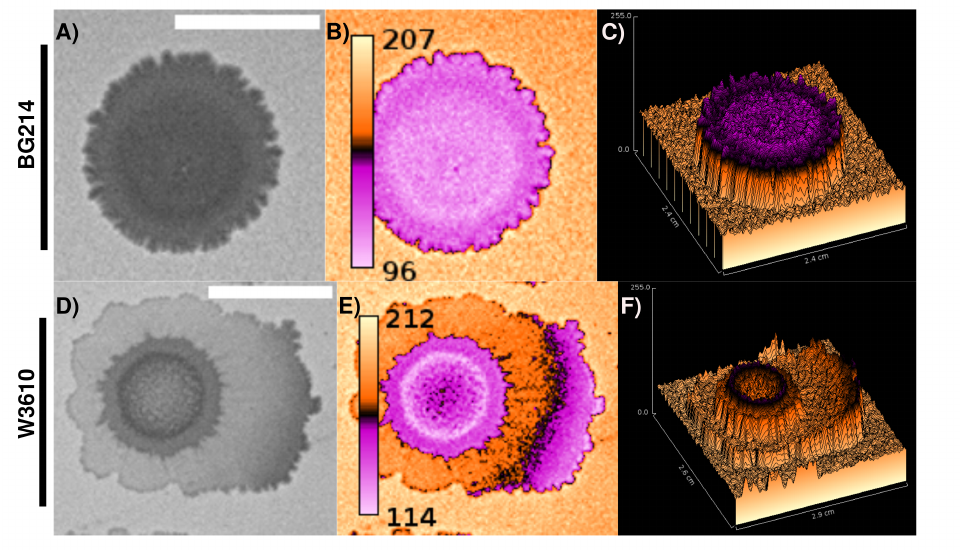
Figure 2. Characteristic B. subtilis colony differences. ( A ) BG214 shows characteristic cones located at the edges of the colony. ( B ) The overall absorption is remarkably stronger for the total colony area. Areas outside of the densely packed colony are clearly distinct because light can pass through easier there. Whilst BG214 forms restricted colony of more or less homogenous biomass density, W3610 shows gradients of biomass density represented by more light passing through the observed area. ( C ) Topographic representation of the colorimetric representation of the colony shows a plateau-like distribution of absorption maximum located throughout the whole colony. ( D ) In contrast to ( A ), W3610 shows different absorption densities, illustrating the strong ability of the phenotype to swarm. ( E ) Areas where cells are not densely packed allow more light to pass. ( F ) Inverted representation of W3610 shows unidirectional increase in waveform indicated by increased absorption. Furthermore, the center of the colony is not a plateau but indicates a ring shape separating the interior. It can be concluded that the wild-type W3610 phenotype is more agile regarding its invasiveness toward the surrounding medium. Figure created using Inkscape 0.92.3, available at: https://www.inkscape.org (accessed on 15 September 2022) and ImageJ2/FIJI 2.7.0/1.53t, (available at: https://fiji.sc/ (accessed on 15 September 2022)). False-colored in ‘ICA3’. Scale bars = 1